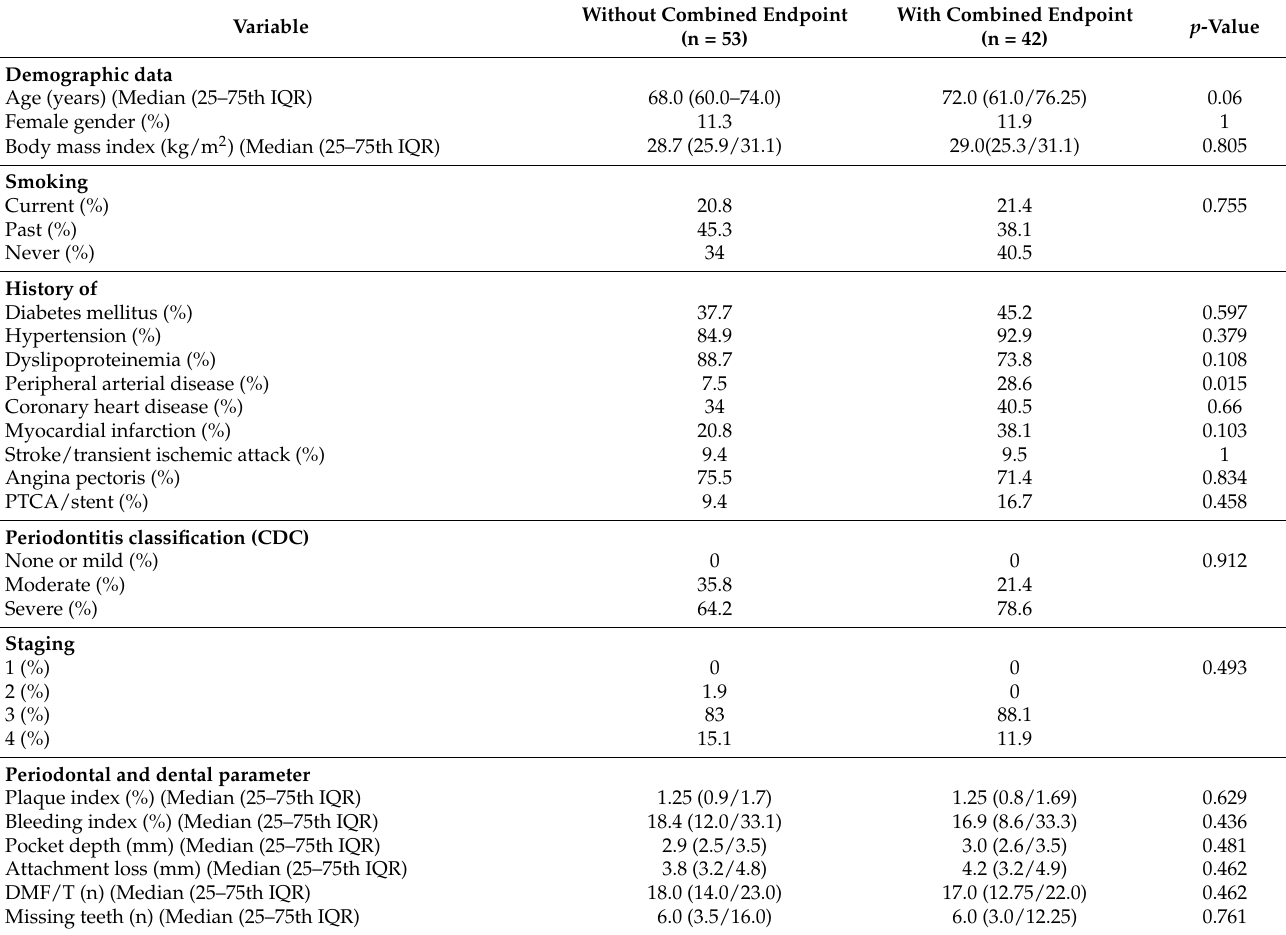
Table 1. Demographic and clinical characteristics (including demographical and anamnestic data, history of previous diseases, and periodontal status) considering the 3-year cardiovascular outcome (combined endpoint refers to the occurrence of major adverse cardiac and cerebrovascular events criteria: 1. No event; 2. Myocardial infarction; 3. Low cardiac output syndrome; 4. Ventricular tachycardia; 5. Angina pectoris; 6. Renewed revascularization surgery; 7. Cardiac decompensation; 8. Peripheral circulatory failure; 9. Stroke/Transient ischemic attack/Prolonged reversible ischemic neurological deficit; 10. Cardiac death; and 11. Stroke death) (PTCA, percutaneous transluminal coronary angioplasty; DMF/T, decayed missing